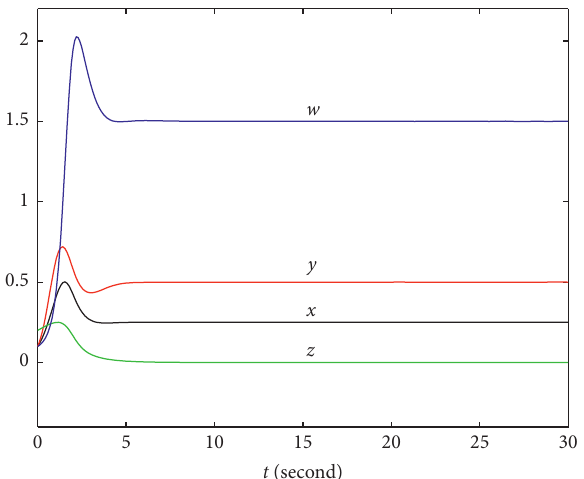
Figure 6: The values a � 2, b � 3, c � 0.5, d � 1, e � 2, f � 2, and g � 2 are used. So, we get the stable solution ( x � 0.25, y � 0.5, z � 0, and w � 1.5).